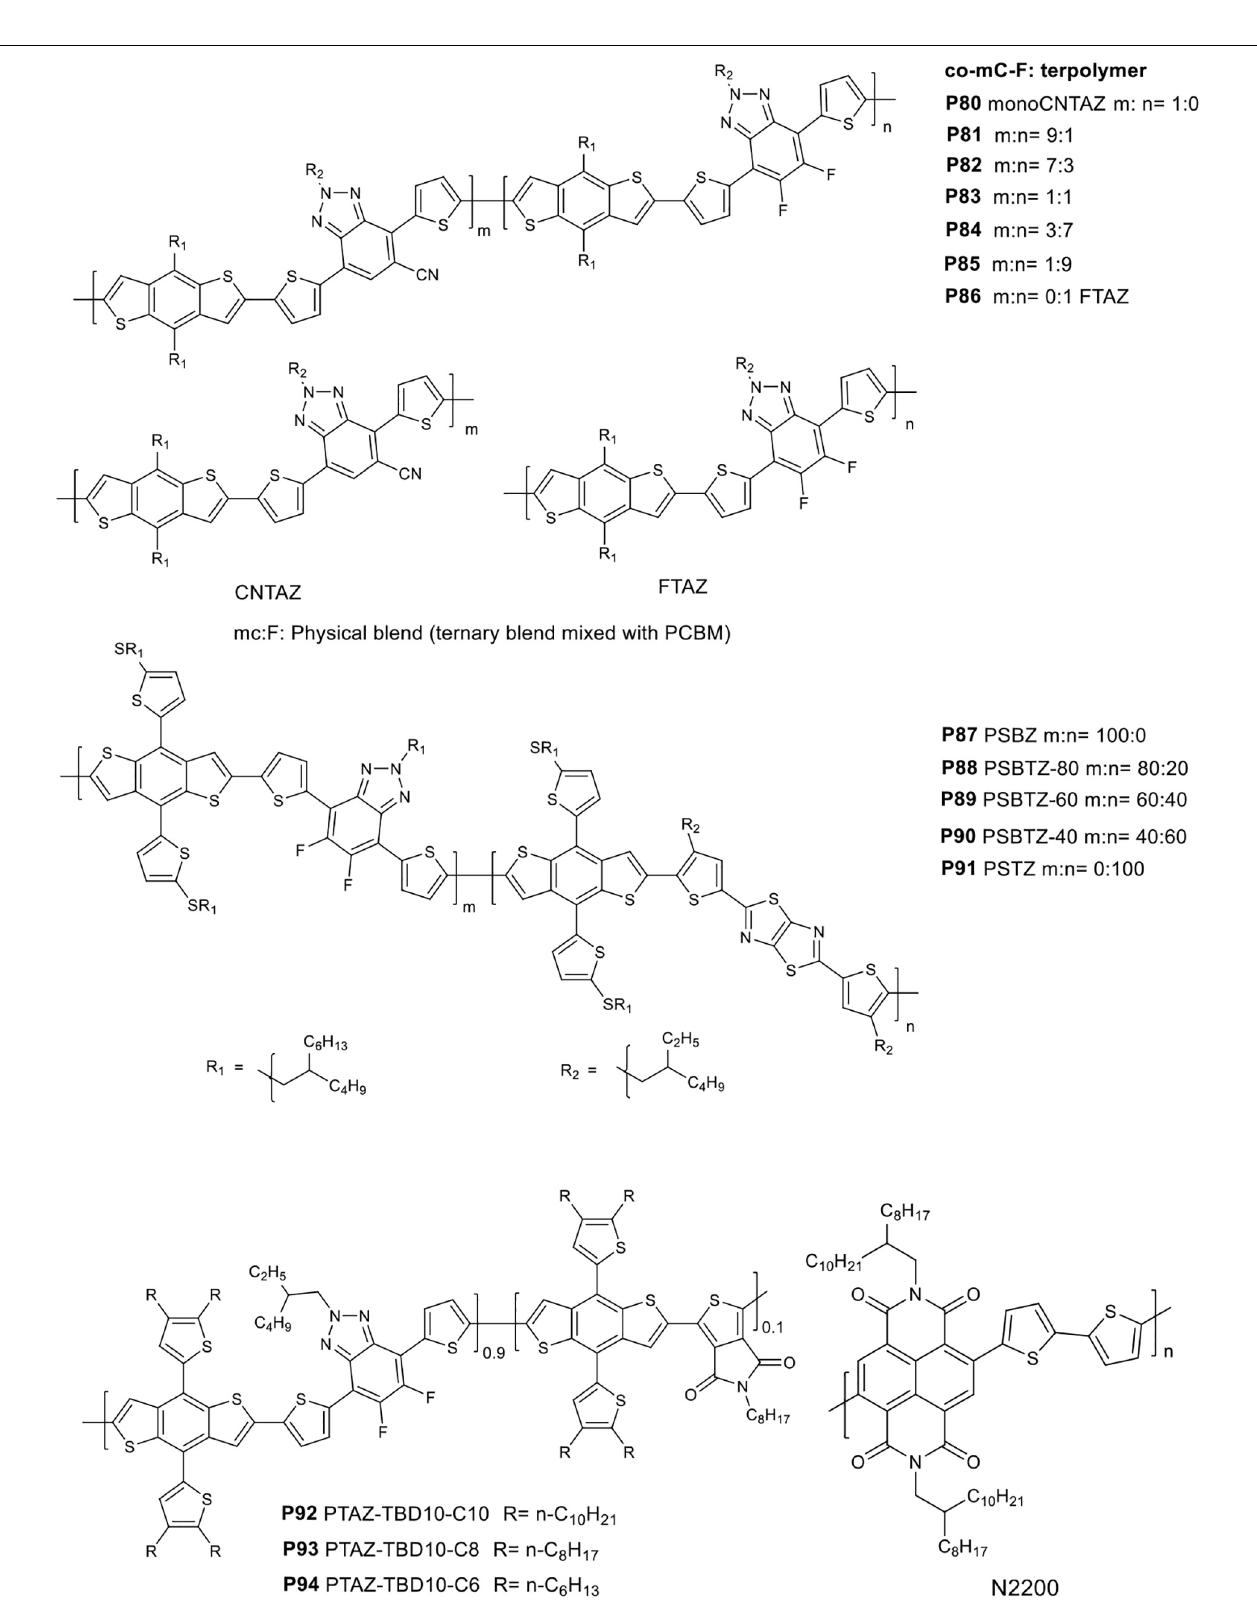
FIGURE 8 | Donor polymers based on benzotriazole ( P80 – P94 ) and N2200.